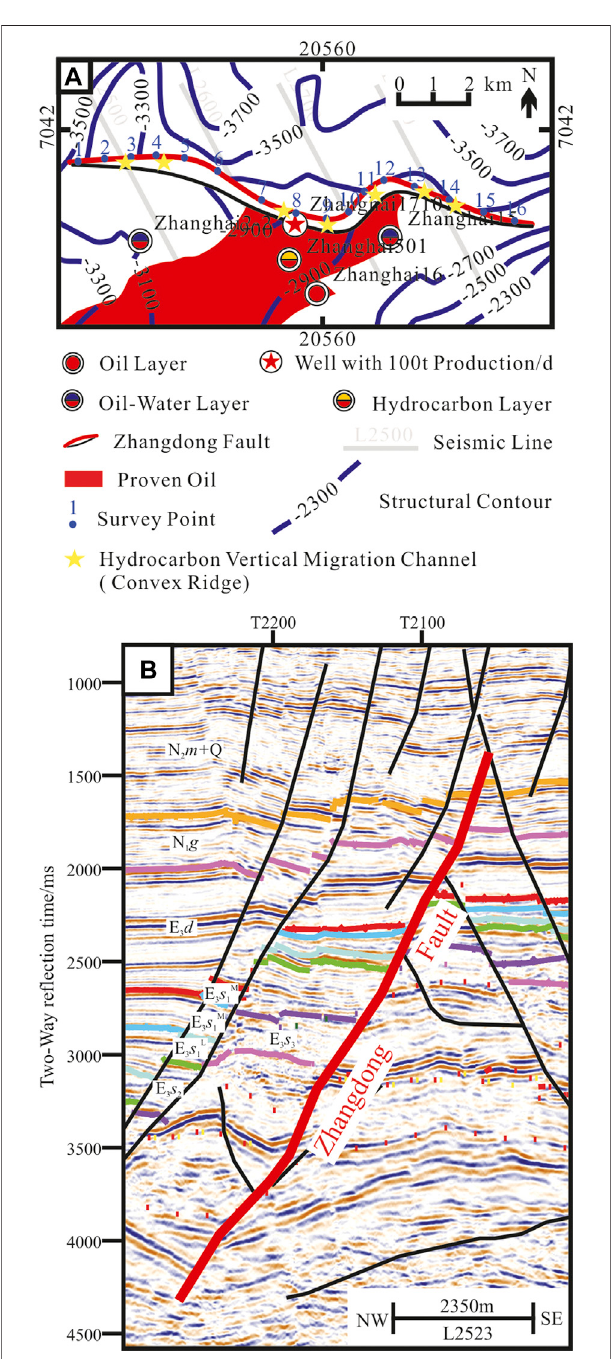
FIGURE 2 | Relation diagram of the Zhangdong Fault development and oil and gas distribution in E 3 s 1L . (A) Plan; (B) Pro fi le.